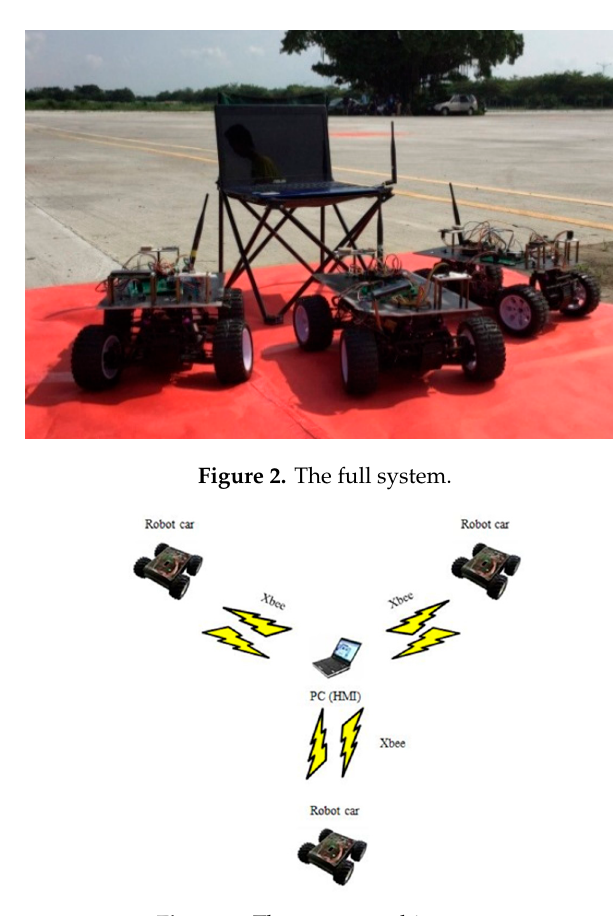
Figure 3. The system architecture.